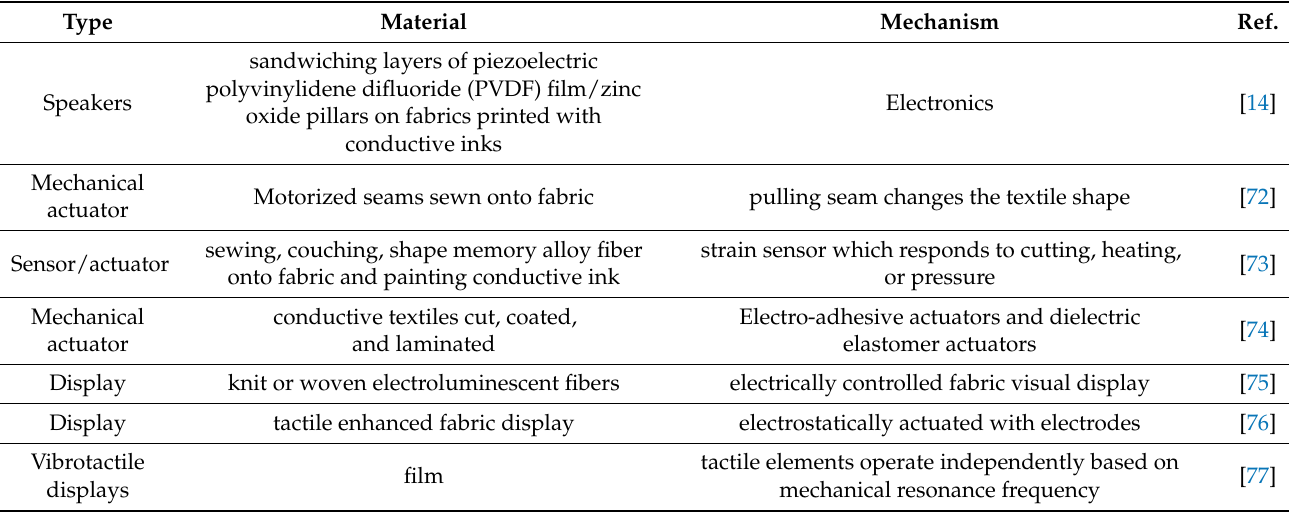
Table 3. Actuators used in electronic